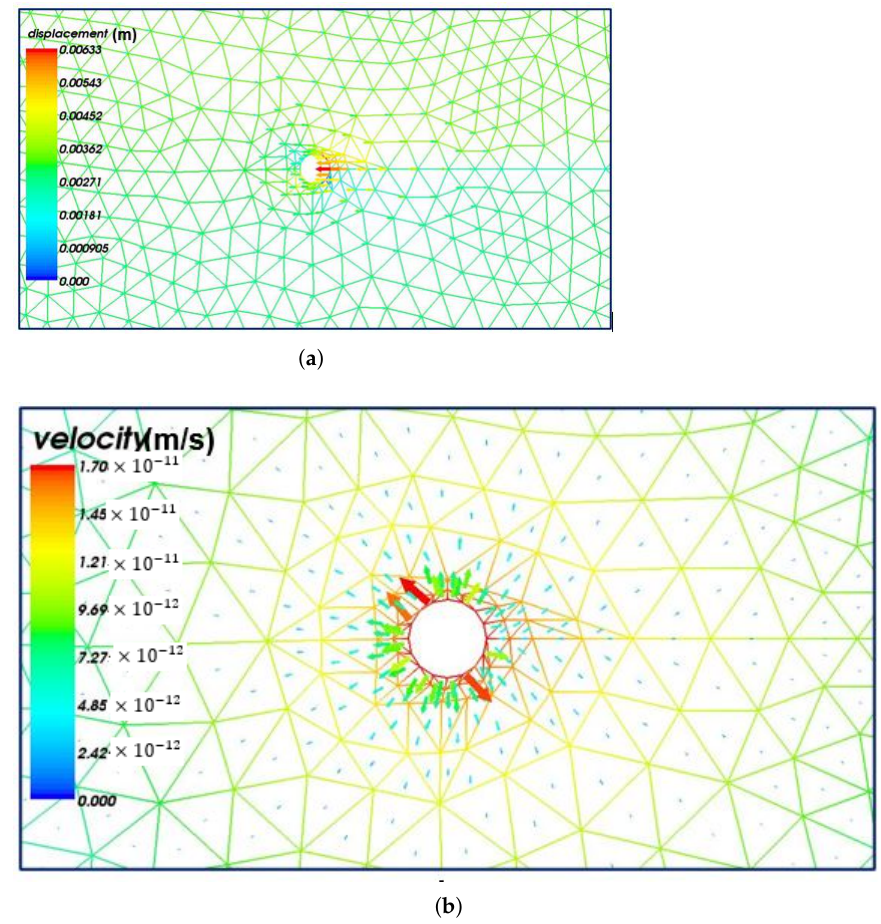
Figure 10. CSMP++ 2D steady-state poroelasticity. ( a ) Rock displacement (m) and ( b ) pore-fluid velocity (m/s) close-up around the 2D